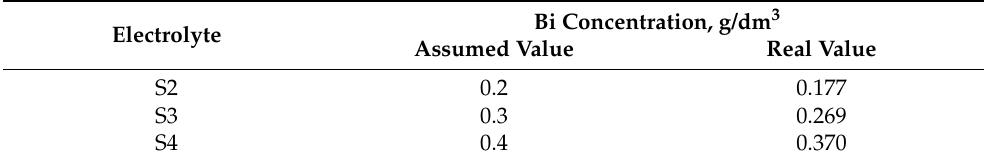
Table 2. Composition of S2, S3, S4 electrolytes used in tests.